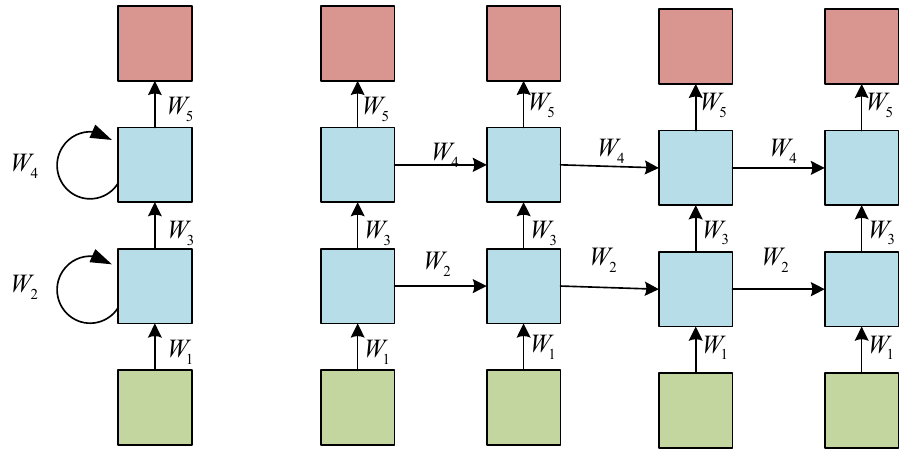
Figure 3. PM2.5 prediction model network structure of the deep recurrent neural network.